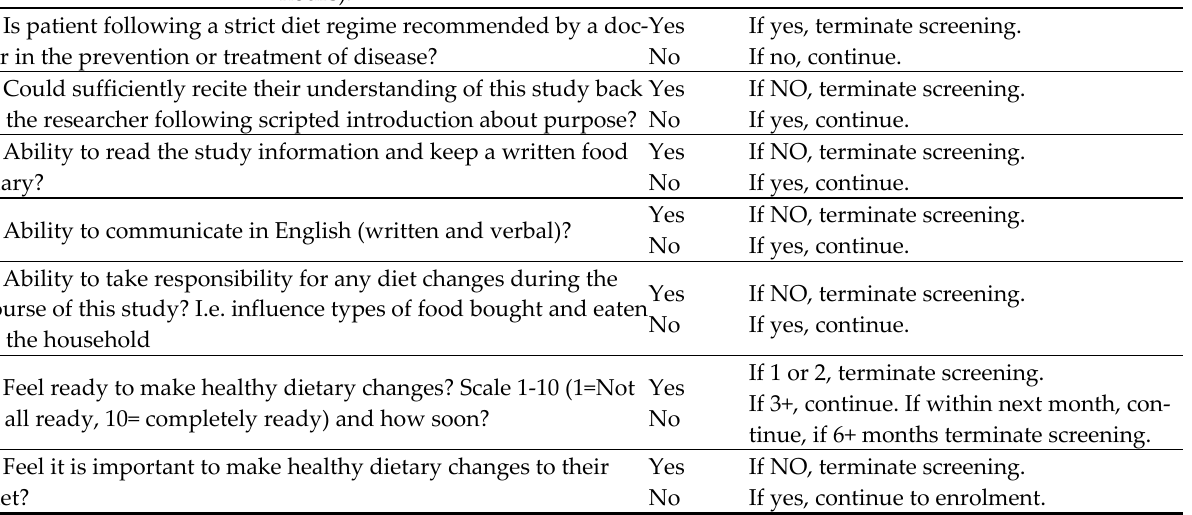
Figure 1. Screening Process DENHAB Intervention.